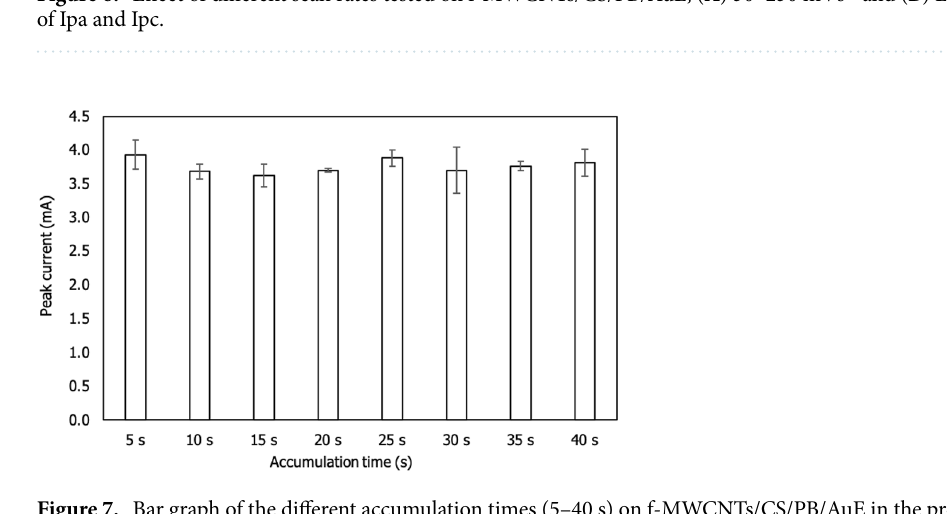
Figure 7. Bar graph of the different accumulation times (5–40 s) on f-MWCNTs/CS/PB/AuE in the presence of 3 ppm Zn 2+ under 200 mVs -1 of scan